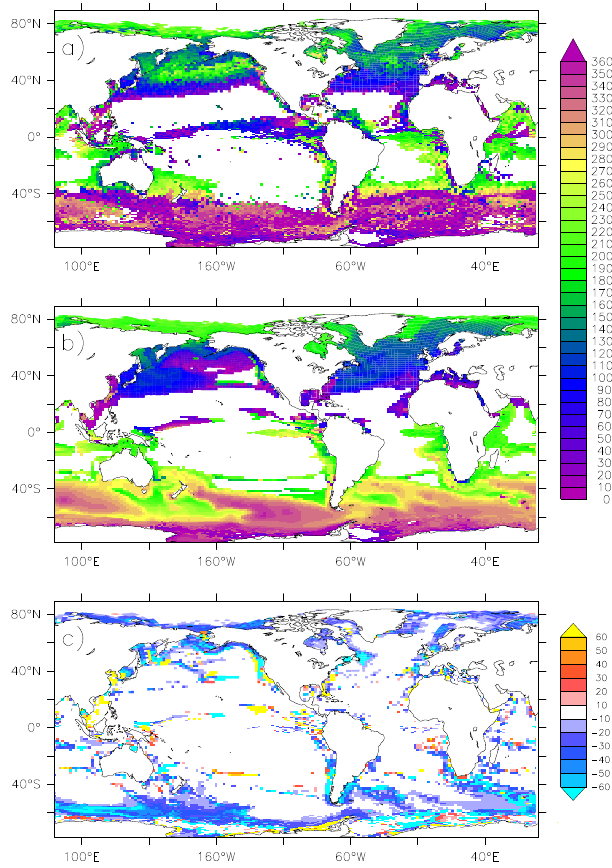
Figure 18. Day of the year at which sea surface chlorophyll is max- imum. Panel (a) corresponds to the observations; panel (b) displays the standard simulation. Panel (c) shows the difference between the LIGHT and the standard experiments. Only the regions where the amplitude of the seasonal cycle exceeds 0.1mgchl a m − 3 are